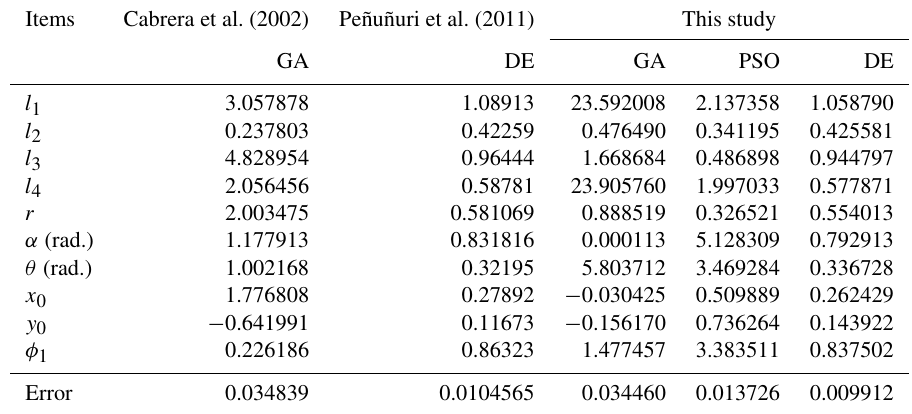
Table 3. Linkage solutions and structural errors obtained in previous work and in this study for Example 3. Items Cabrera et al.